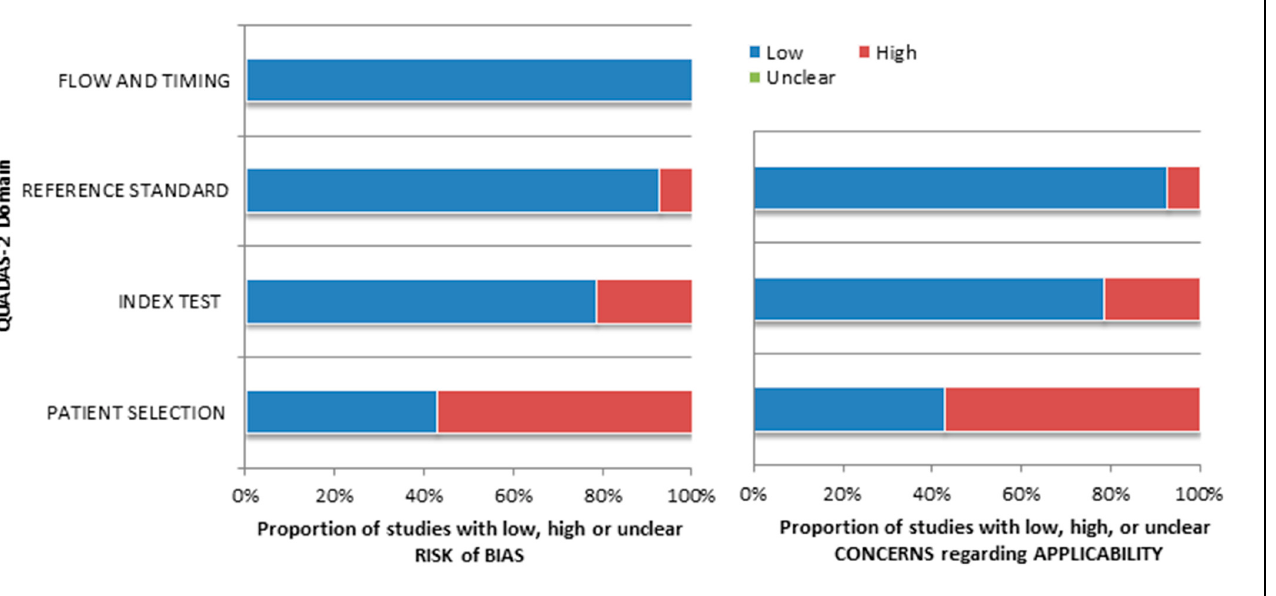
Figure 2. Summary of quality assessment according to the QUADAS-2 tool. The authors classified the papers included in the systematic review as a high risk or low risk of bias or applicability concerns for distinct domains listed in the ordinate axis. In contrast, the abscissa axis shows the percentage of studies. The graph indicates that about 60% of studies suffered a high risk of bias in “patient selection”, whereas a poor risk of bias was observed in “reference standard”, “index test”, and “flow and timing” domains.